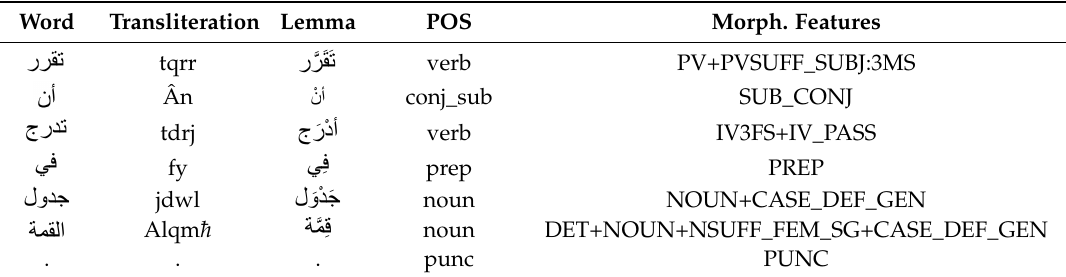
Table 1. An example of the Arabic features in our approach.